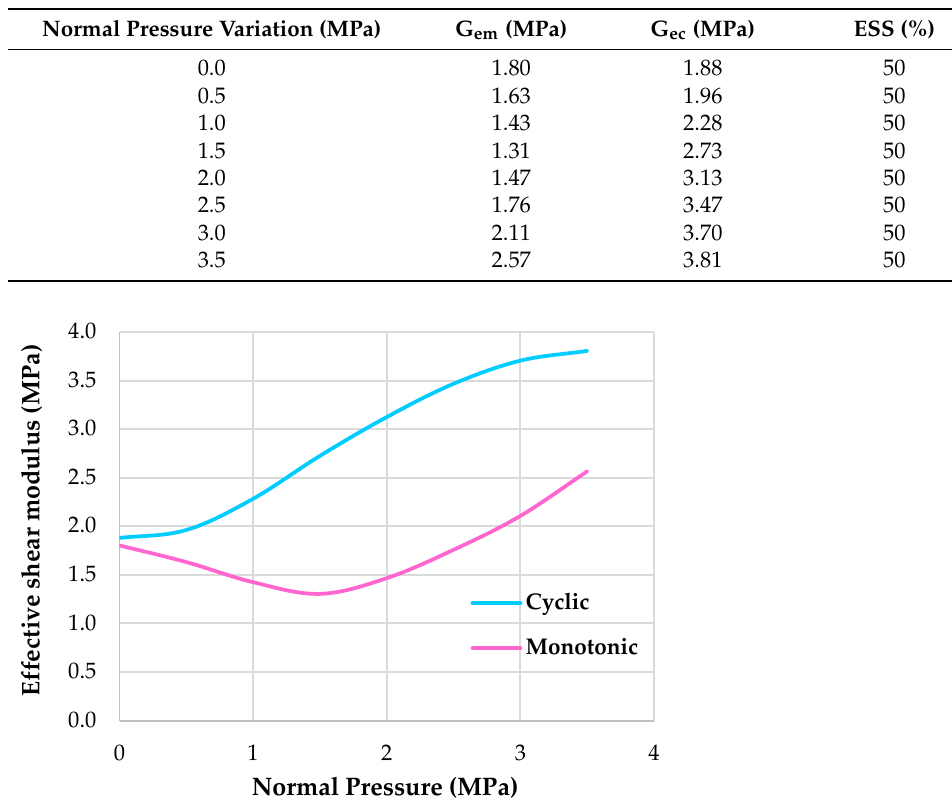
Figure 12. Definition of effective stiffness . Red line is the bi-linear relationship between force and displacement, while the green dash line is the equivalent stiffness. Table 3. Calculated shear moduli of the proposed model under monotonic and cyclic loading at the target shear stain.